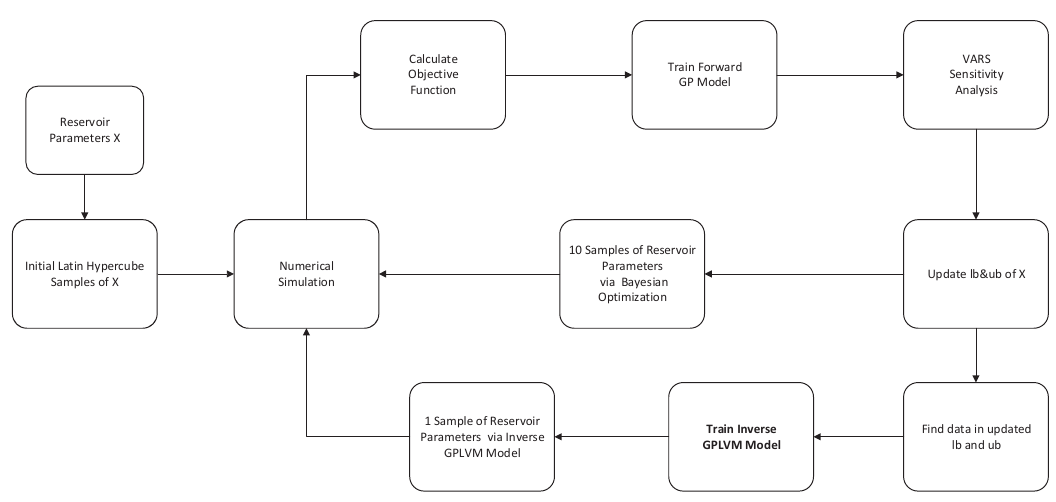
Figure 1. Flowchart of the proposed GPLVM-VARS for assisted history